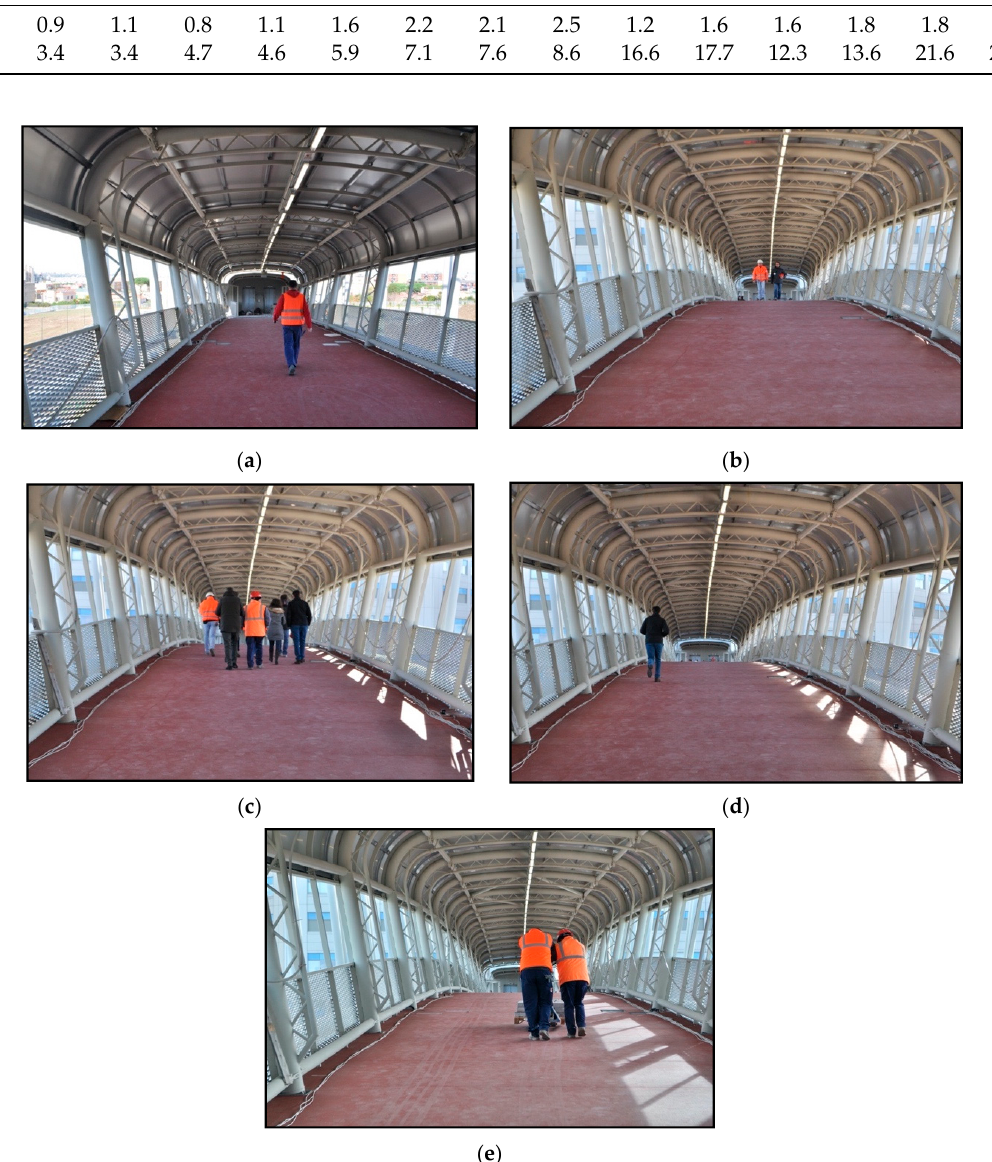
Figure 8. “Ospedale del Mare” footbridge: vibration measurements under pedestrian-induced loadings: 1 walking pedestrian ( a ), 2 walking pedestrians ( b ), 10 walking pedestrians ( c ), 1 running pedestrian ( d ), 2 walking pedestrians with loaded trolley ( e ).